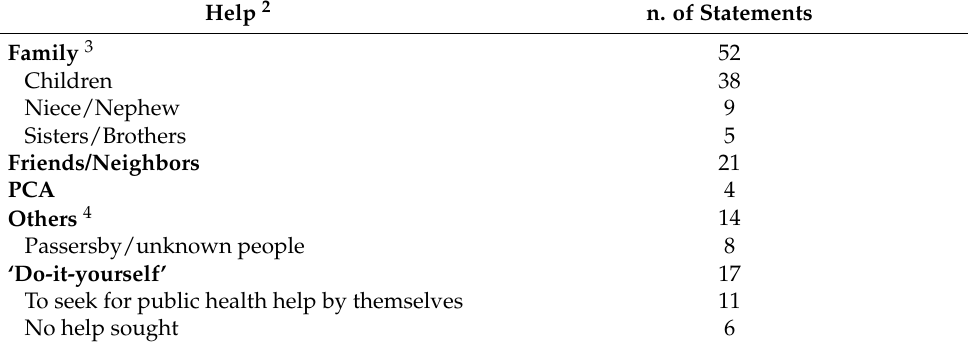
Table 6. First help for health emergencies (at least one type of help) 1